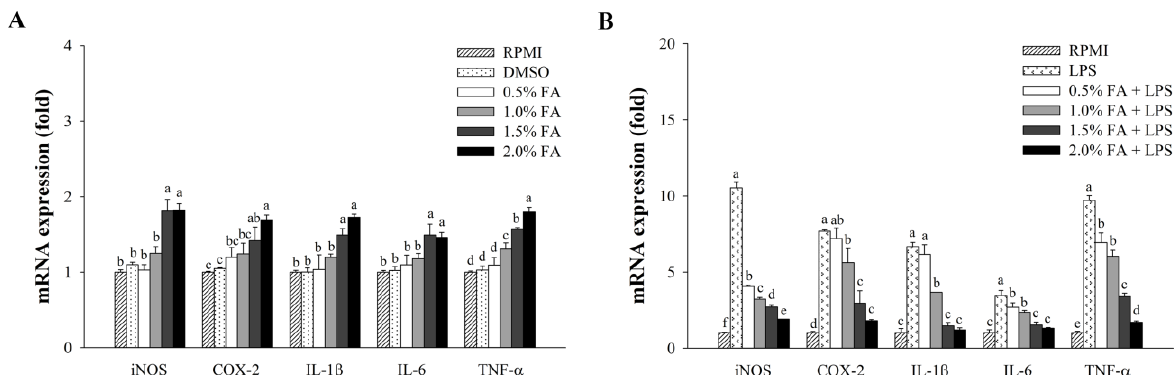
Figure 3. The effect of HAGF on gene expression associated with immune responses in RAW264.7 cells. ( A ) The mRNA expression without LPS stimulation. ( B ) LPS-stimulated mRNA expression. Values are shown as means ± SD ( n = 3). Different letters (a–f) are used to reflect statistical differences at p < 0.05. FA = fatty acid.